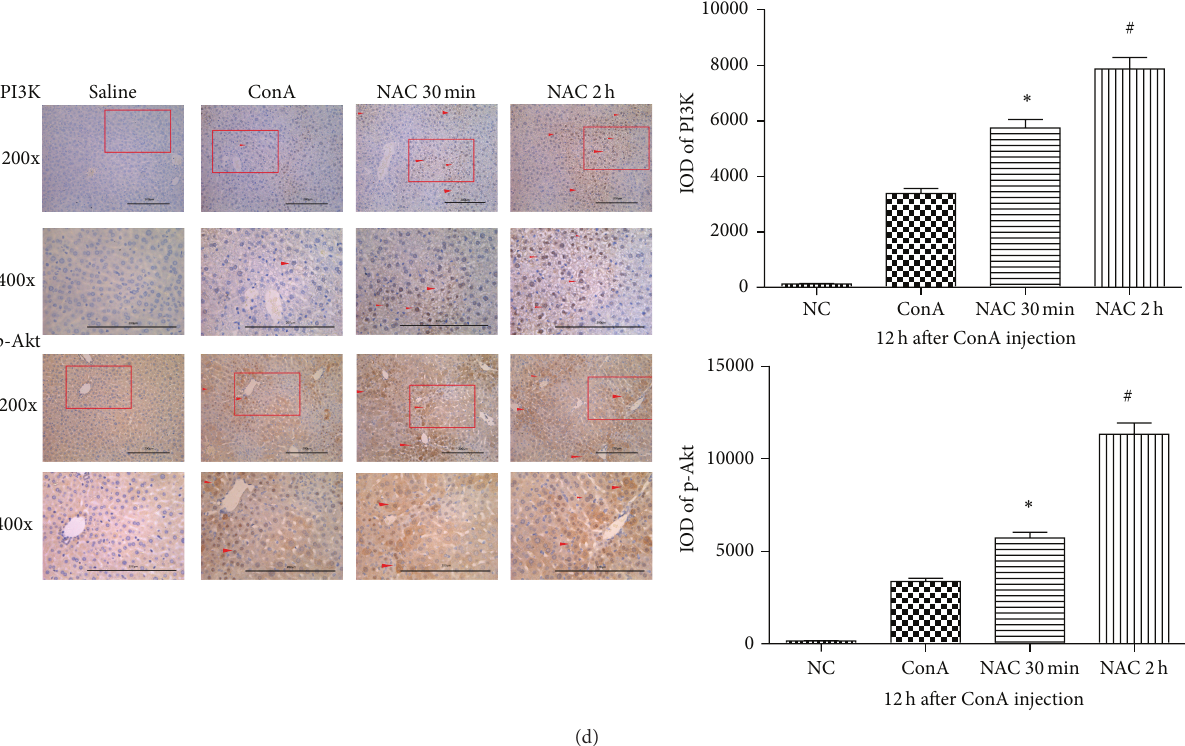
Figure 3: The effect of NAC on expression of PI3K/Akt pathway in ConA-induced autoimmune hepatitis. (a) The expression of PI3K and Akt on mRNA levels was detected by real-time PCR. Data are expressed as mean ± SD ( 𝑛 = 6 ; ∗ 𝑃 < 0.05 for ConA versus NAC 30 min; # 𝑃 < 0.05 for NAC 30 min versus NAC 2h). (b) The expressions of PI3K, p-Akt, and Akt on protein levels were detected with western blot. The expressions of PI3K, p-Akt, and Akt on protein levels of macrophages and hepatocytes were detected by western blot at 12h time point. (c) TheresultsofwesternblotwereanalyzedwithQuantityOne.Dataareexpressedasmean ± SD( 𝑛 = 6 ; ∗ 𝑃 < 0.05 forConAversusNAC30 min; # 𝑃 < 0.05 for NAC 30 min versus NAC 2h). (d) The expressions of PI3K and p-Akt on protein levels were detected by immunohistochemistry staining in hepatic tissues at 12h ( × 200 and × 400 magnification). The positive cells were indicated with red arrows. The result was analyzed using Image-Pro Plus 6.0. Date are showed as mean ± SD ( 𝑛 = 6 ; ∗ 𝑃 < 0.05 for ConA versus NAC 30 min; # 𝑃 < 0.05 for NAC 30min versus NAC